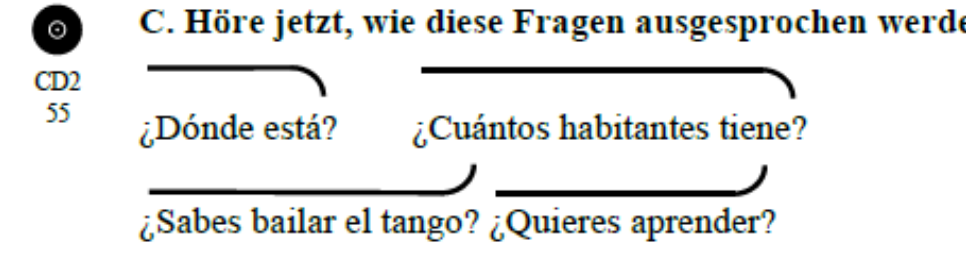
Figure 2. Adapted illustration of the intonational difference between partial and yes-no questions in Spanish in the 2011 textbook Vía Rápida (p. 259, Ainciburu 2011; Translation of the German sentence: ‘Now listen to how these questions are pronounced.’)